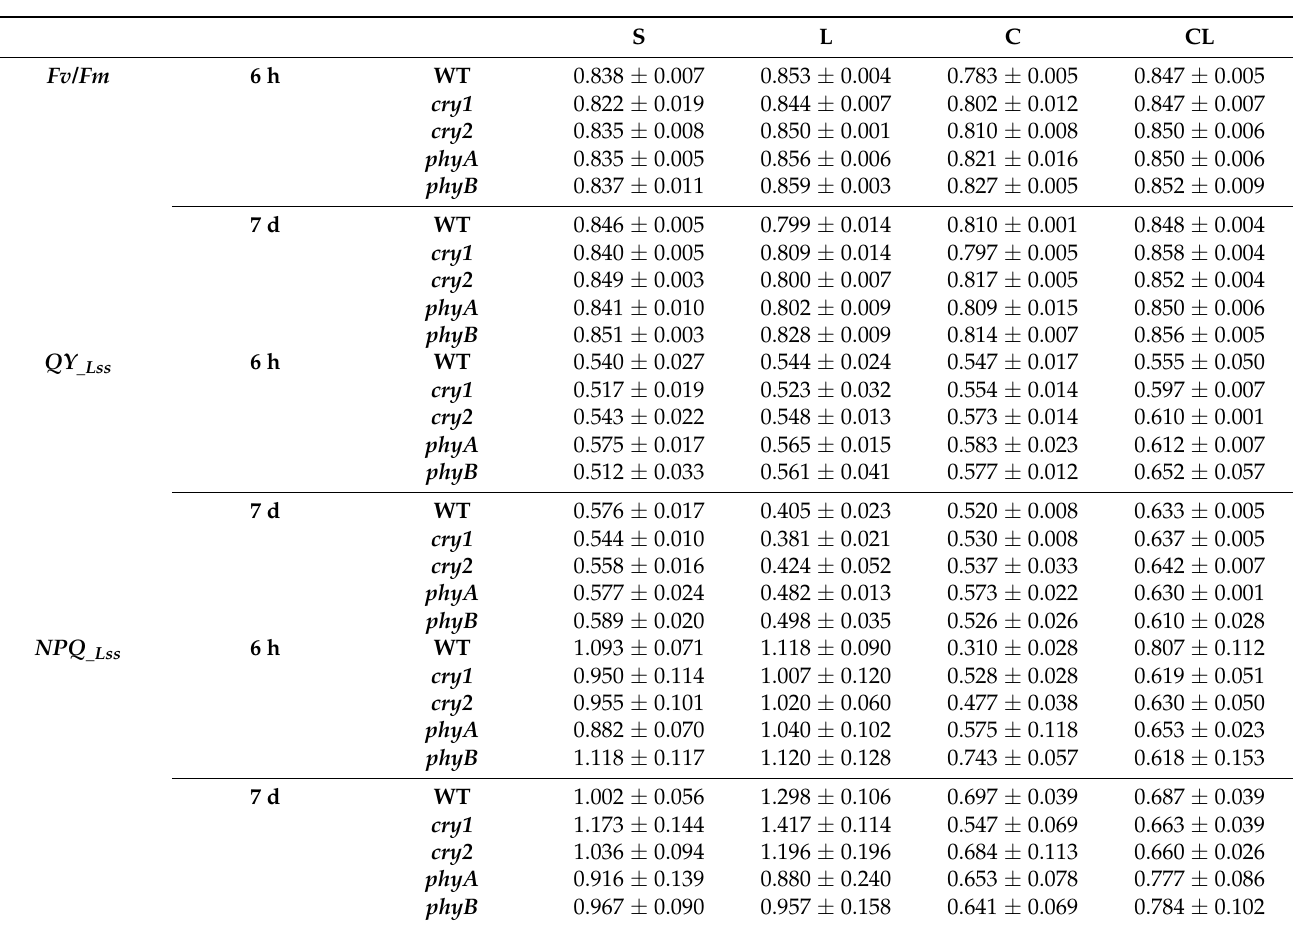
Table 1. Photosynthetic parameters: the maximum quantum yield of photosystem II (PSII) in the dark-adapted state (F v /F m ), steady-state quantum yield (QY _Lss ) and non-photochemical quenching (NPQ _Lss ) of PSII. Selected genotypes were exposed to standard (S), low light (L), cold (C) and combined cold and low light (CL) conditions for 6 h or 7 d. Means ± SD of six independent developed leaves are presented. WT, wild type. Between-treatment and between-genotype differences were evaluated by one-way ANOVA with Tukey’s test ( p < 0.05, n = 6)—see Table